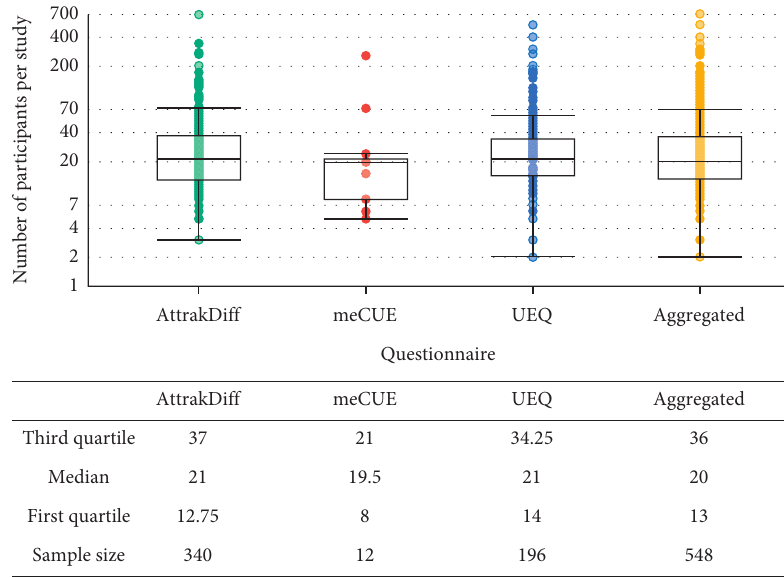
Figure 4: Number of participants per study by standardized